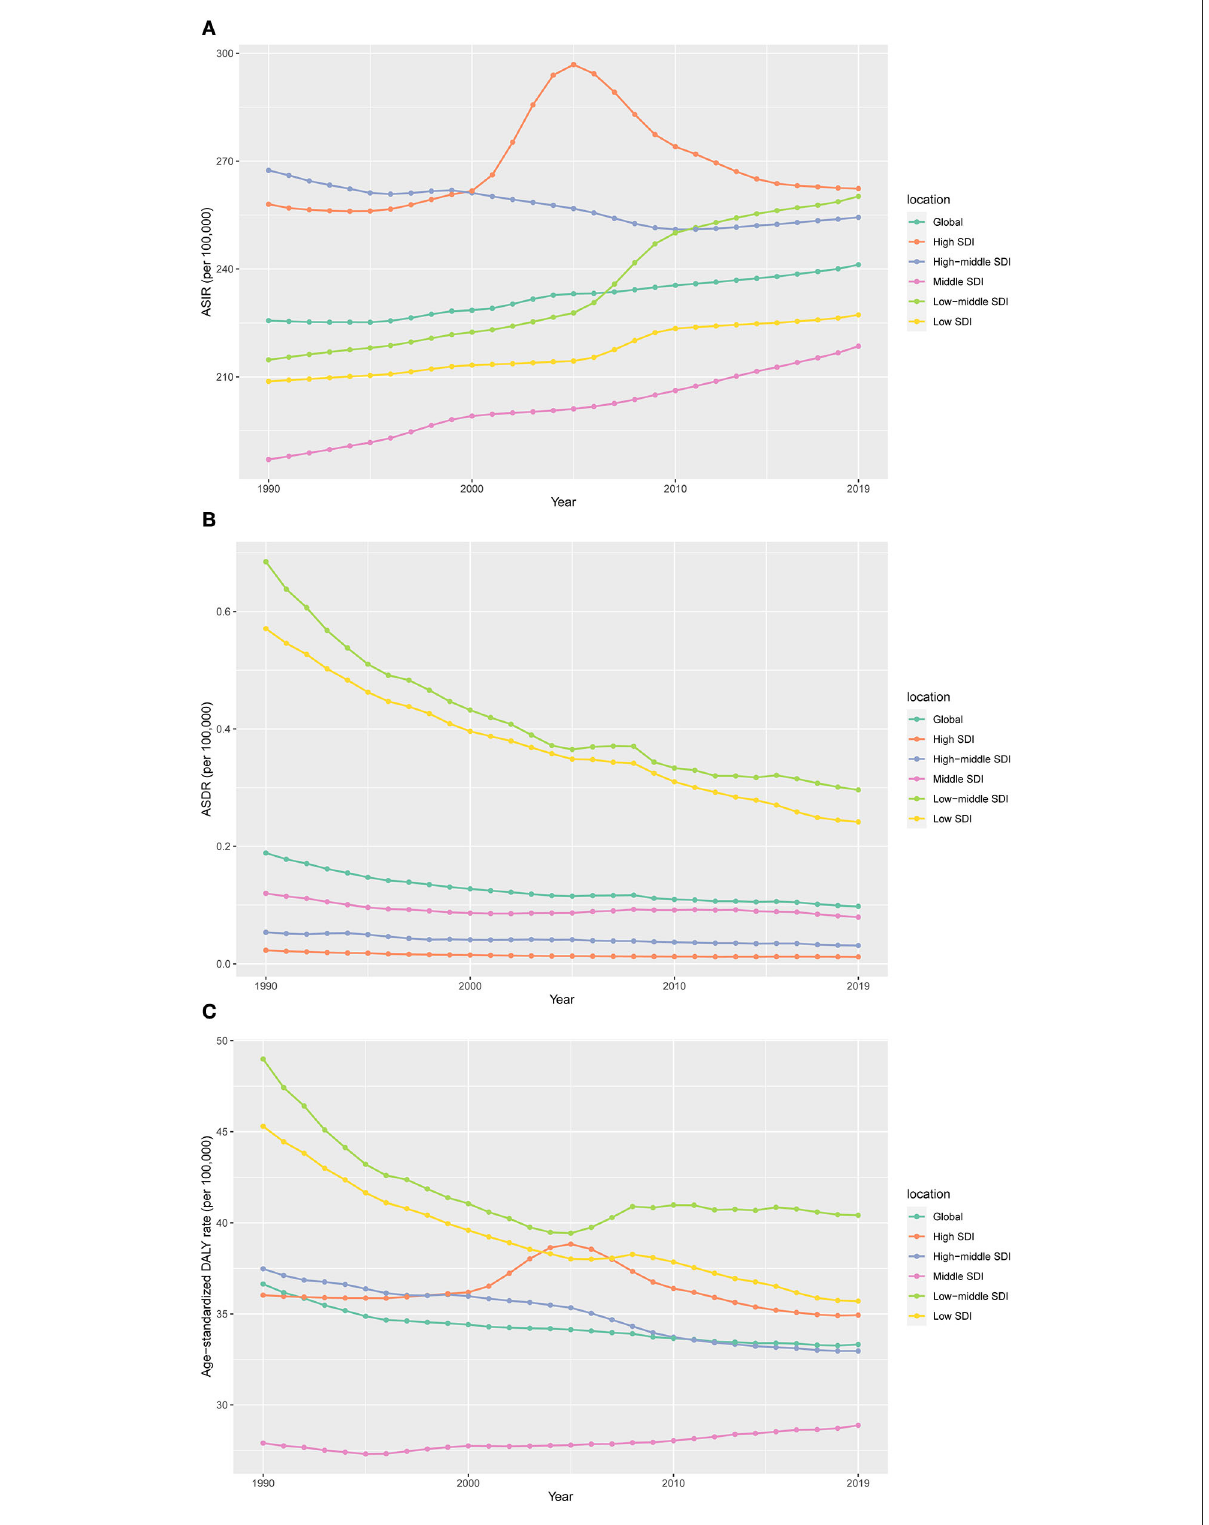
FIGURE1 The change trends of age-standardized incidence, death, and DALY rate among different SDI quintiles. (A) Age-standardized incidence; (B) age-standardized death; (C) age-standardized